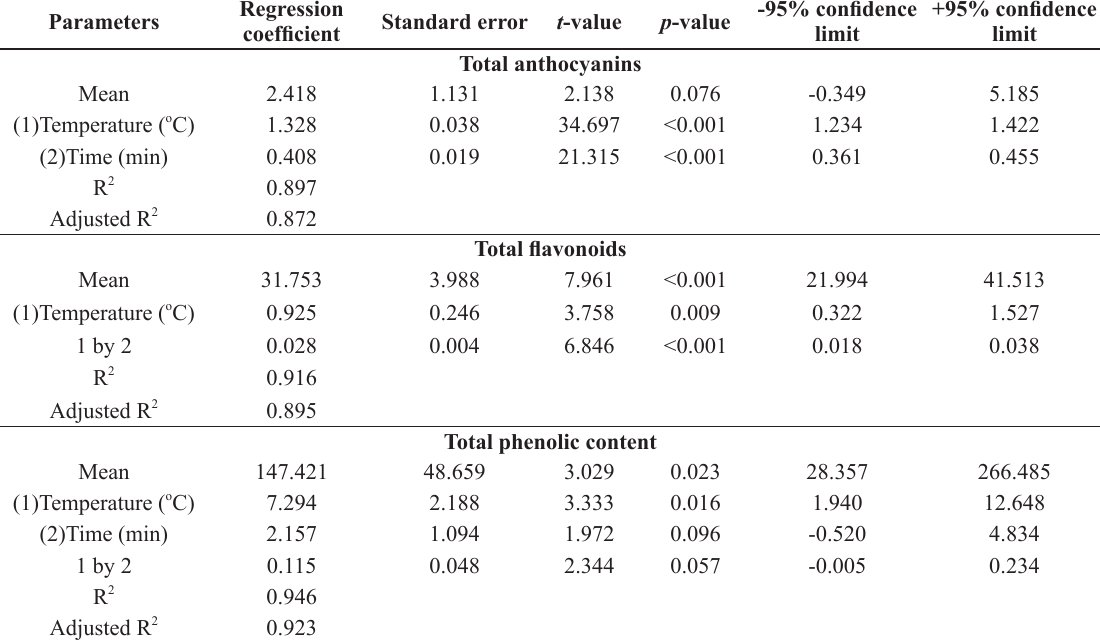
Regression coefficients obtained by multiple regression analysis (response surface methodology) to assess the effects of time and temperature of extraction of total anthocyanins, flavonoids, total phenolic content, and antioxidant activity of Ocimum basilicum L. leaf